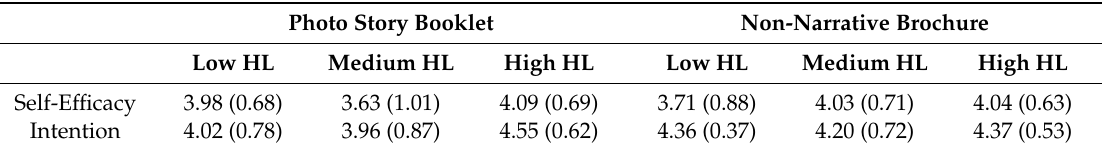
Table 2. Average levels of self-e ffi cacy and behavioral intention for both conditions for each Health Literacy Group (means and standard deviations) in Germany.